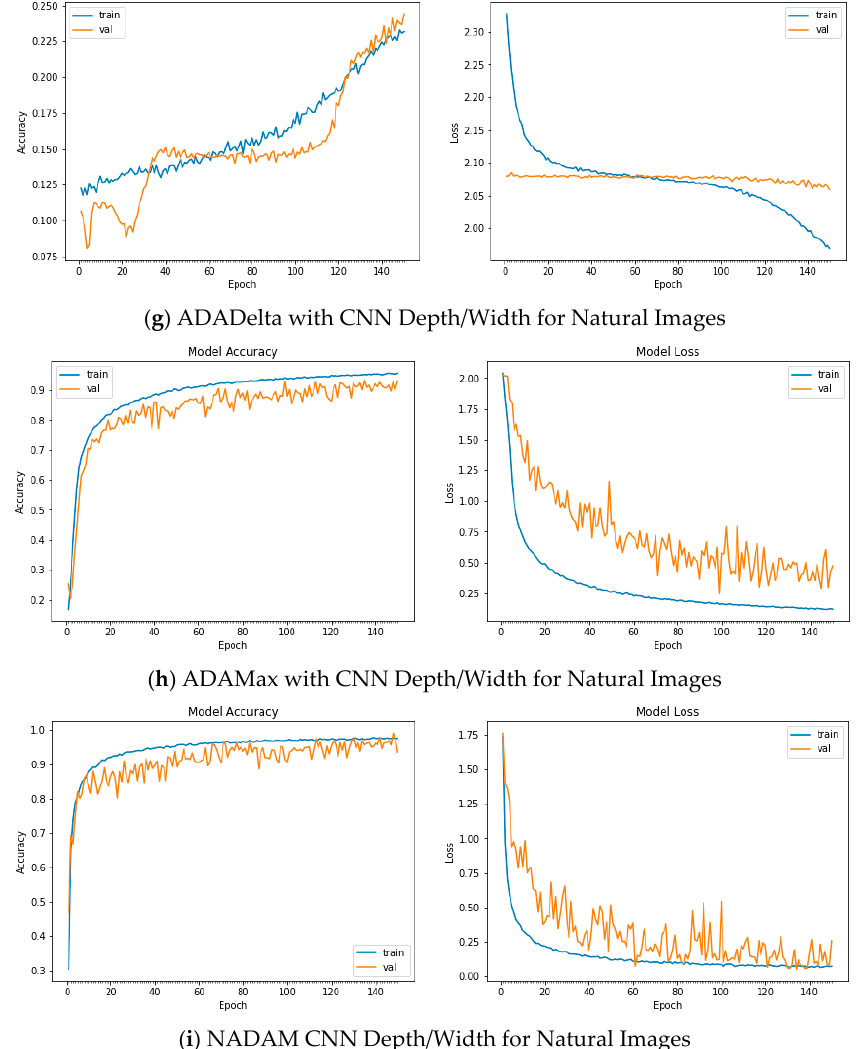
Figure A8. Plots of Train and Validation Test accuracies and losses of the CNN model with varying depth/width for Natural Images: ( a ) Vanilla SGD; ( b ) SGD momentum; ( c ) SGD Nesterov momentum; ( d ) ADAGrad; ( e ) RSMProp; ( f ) ADAM; ( g ) ADADelta; ( h ) ADAMax; ( i ) NADAM.